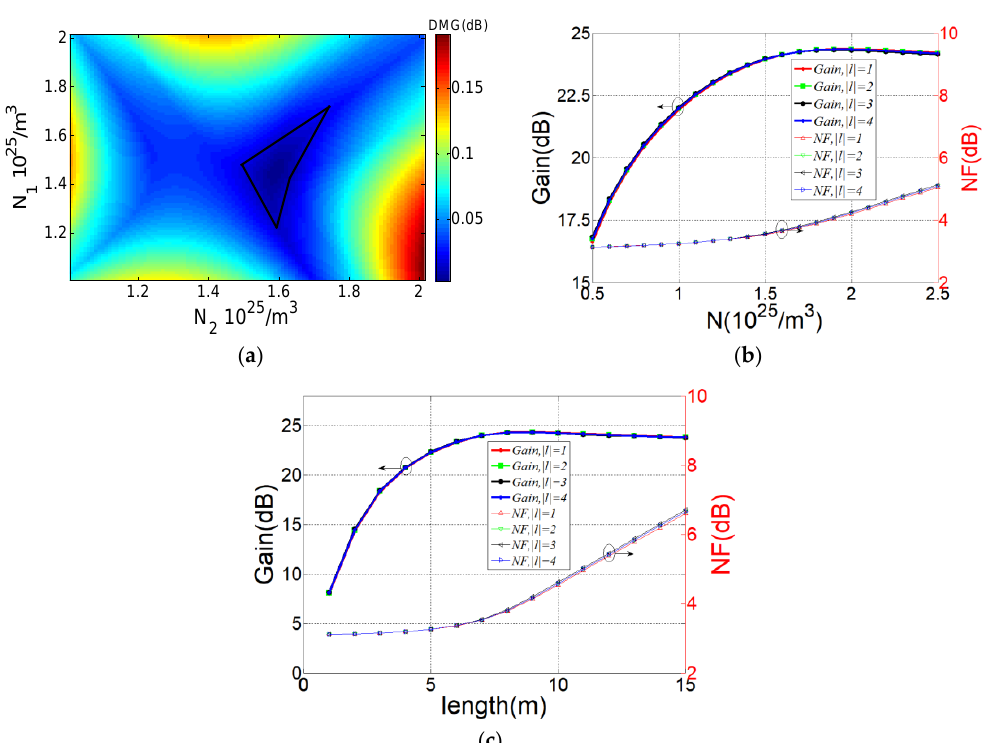
Figure 4. ( a ) Differential mode gain (DMG) as a function of the doping concentration N 1 and N 2 , ( b ) Gain and noise figure (NF) as a function of the doping concentration N ; ( c ) Gain and NF versus fiber length.